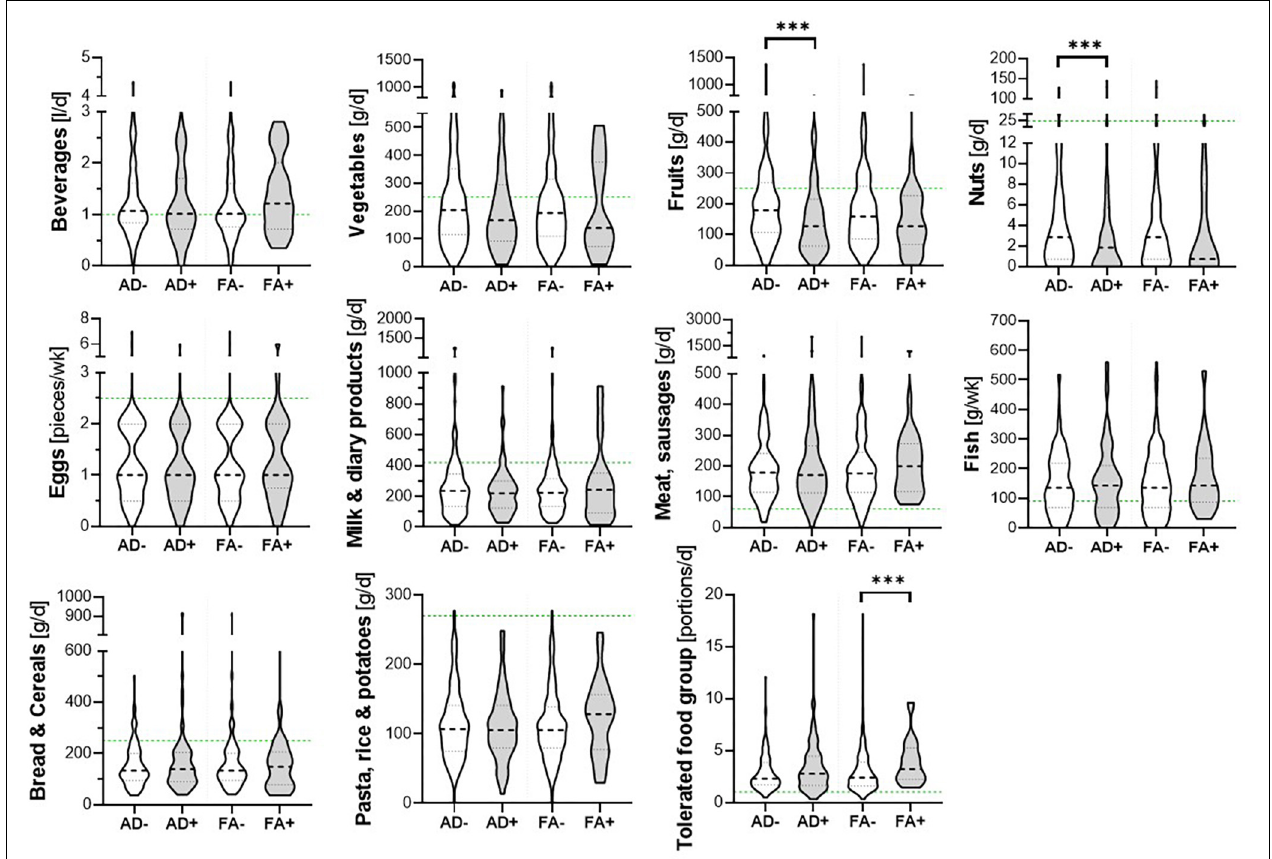
FIGURE 1 | Food groups and atopic outcomes. Children’s consumed food groups at the age of 10 years according to having developed atopic dermatitis (AD +) or food allergy (FA +) within the first 10 years of life or not (AD- and FA-, respectively). Green line: OptiMix recommendations for 10–12 year old children. Data are presented as violin plots with median (bold dotted line) and 25 to 75th percentile (dotted line), n = 211. ***Significant difference ( p < 0.05) between AD+/AD- or FA+/ FA-, respectively (Mann–Whitney U